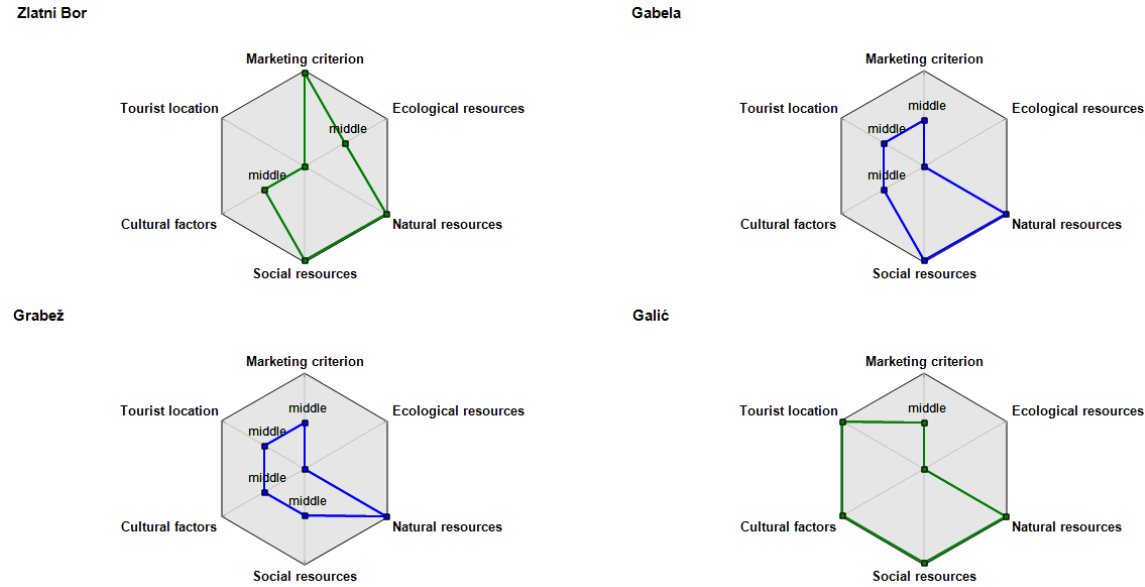
Figure 3. Evaluation of rural tourist facilities by the sub-criteria.